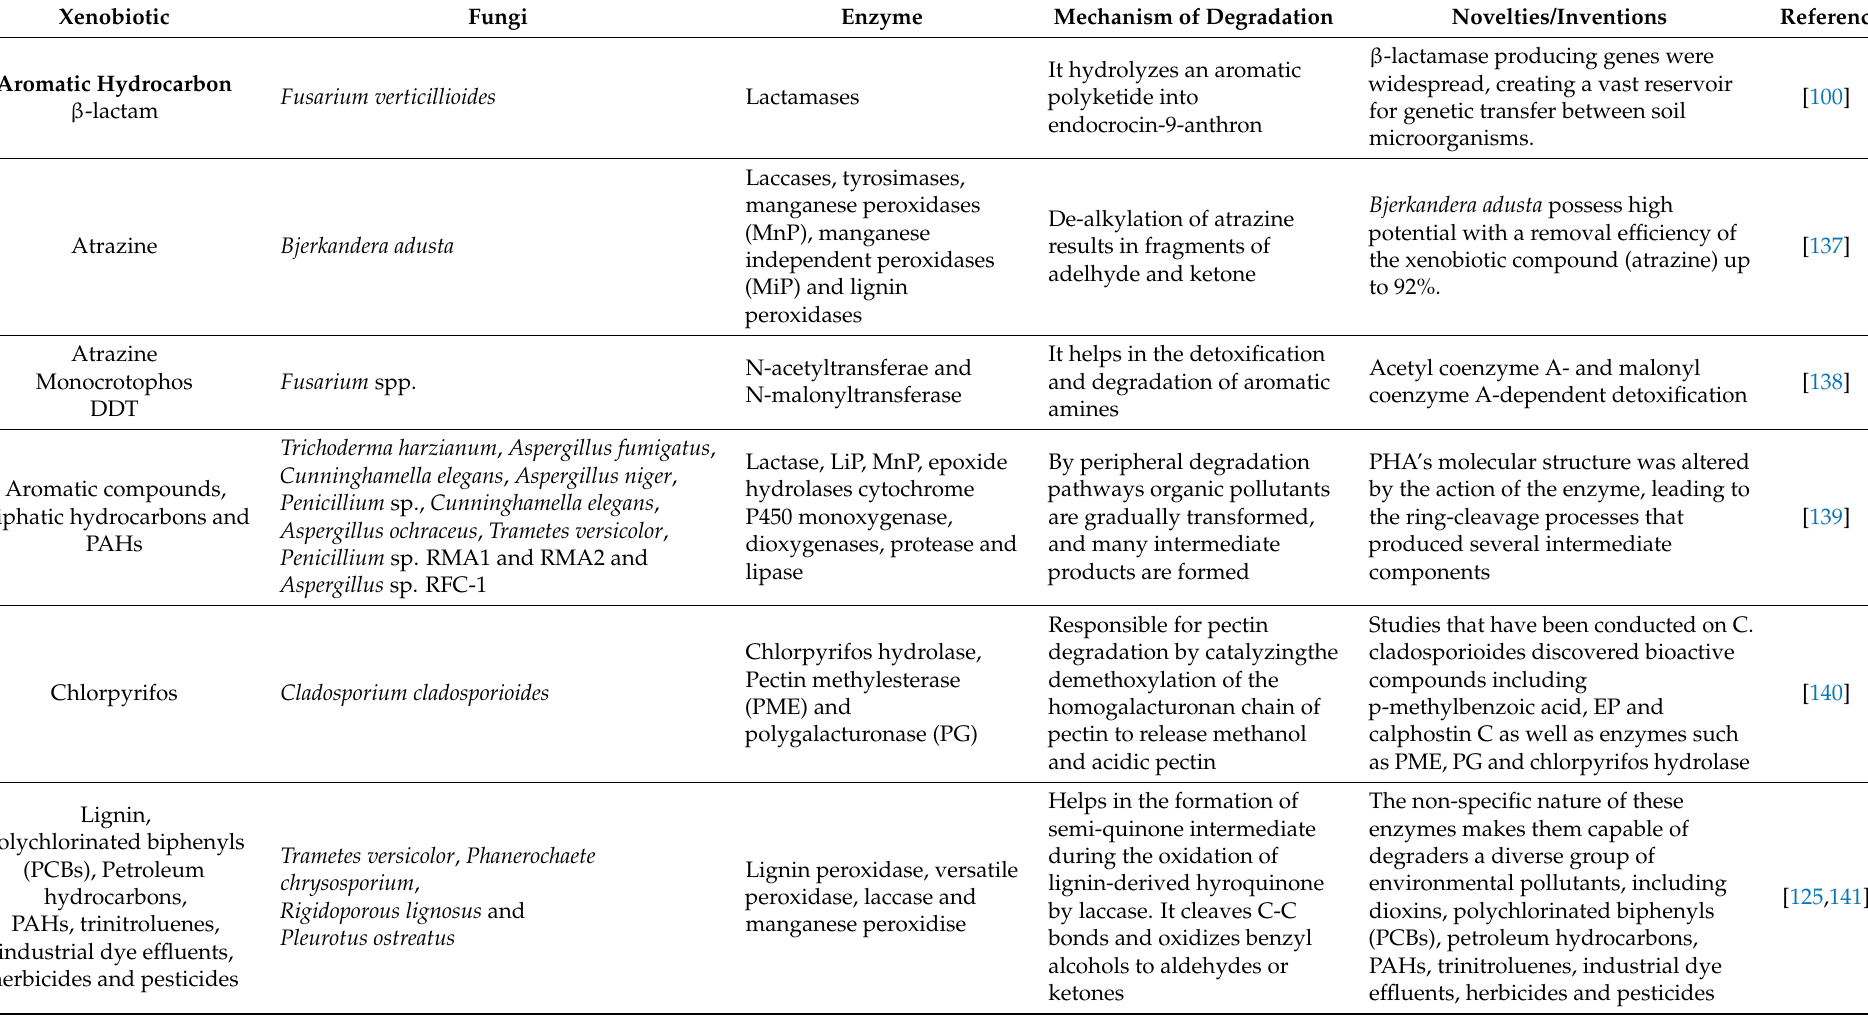
Table 4. Fungi and their working enzymes involved in Xenobiotic